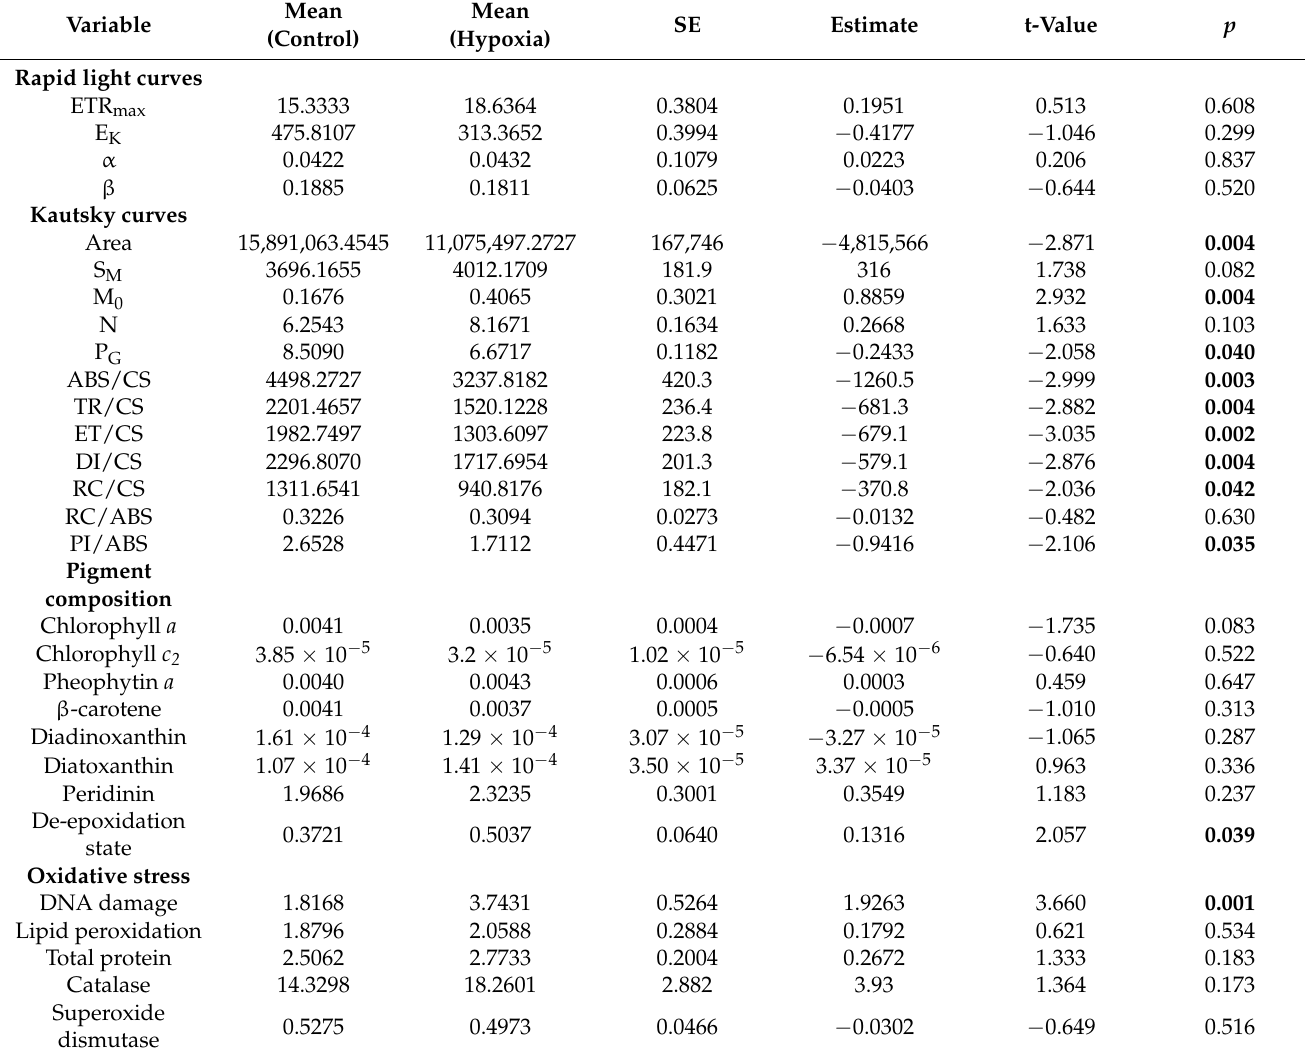
Table 2. GLM outcomes for all the analysed variable responses of corals exposed to control